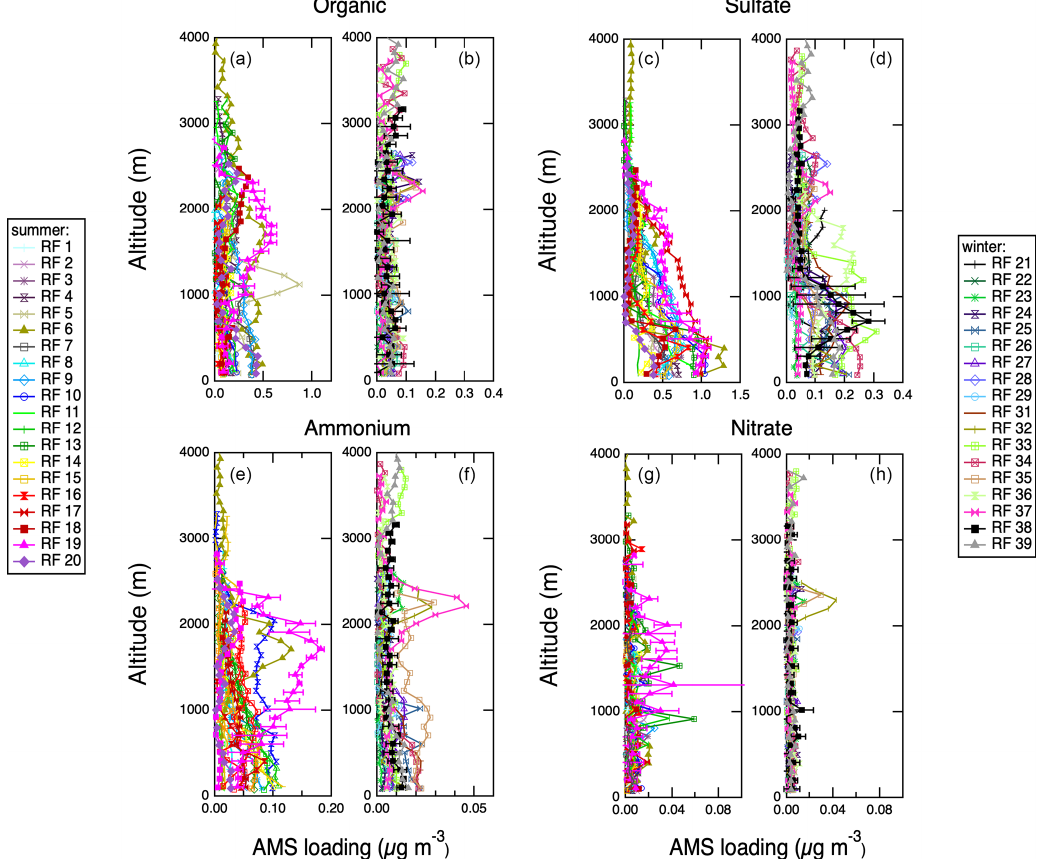
Figure 8. Vertical profiles of AMS aerosol chemistry measurements acquired during spiral profiles shown in Fig. S1. Representative error bars (1 σ standard deviations) are shown on 1d only for clarity. (a) Organic, IOP 1. (b) Organic, IOP 2. (c) Sulfate, IOP 1. (d) Sulfate, IOP 2.